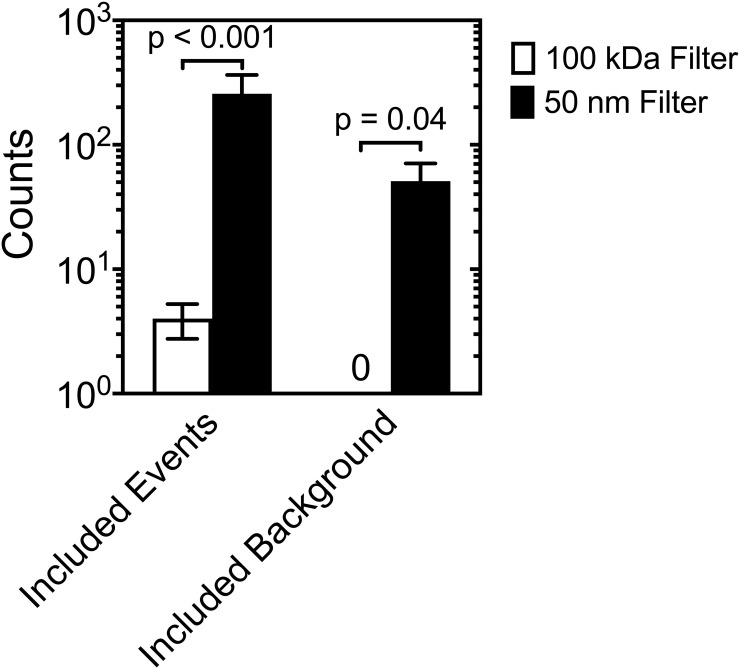
Motive to filter BSA with a 100 kDa filter to reduce false positive background counts for measurements with microfluidic resistive pulse sensing.Counts from 0.1% BSA (w/v) in DPBS prepared by a 100-kDa filter and a 50-nm Isopore filter in a TS-300 microfluidic cartridge. Data were averaged after three independent measurements, of which each consisted of 10 acquisitions of 10 seconds. The background counts were subtracted, and the peak filters were applied. Included events are particle detection events that pass the peak filters, while Included background is electrical noise that is included as a particle detection event by passing the peak filters. Error bars are representative of 95% confidence intervals (n = 3). Statistical significance was quantified with a two-way ANOVA; p values were adjusted for multiple comparisons using a Sidak test.